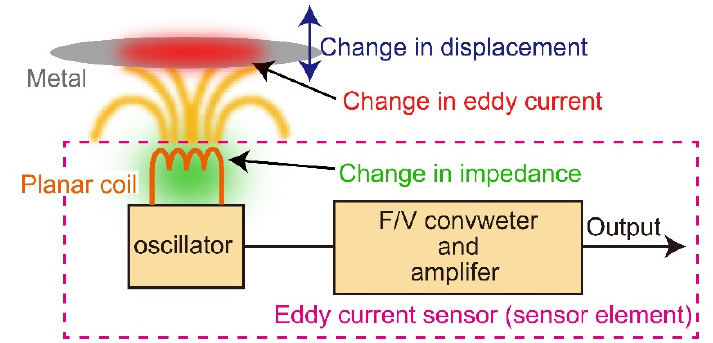
Figure 2. Schematic of the eddy current displacement sensor.